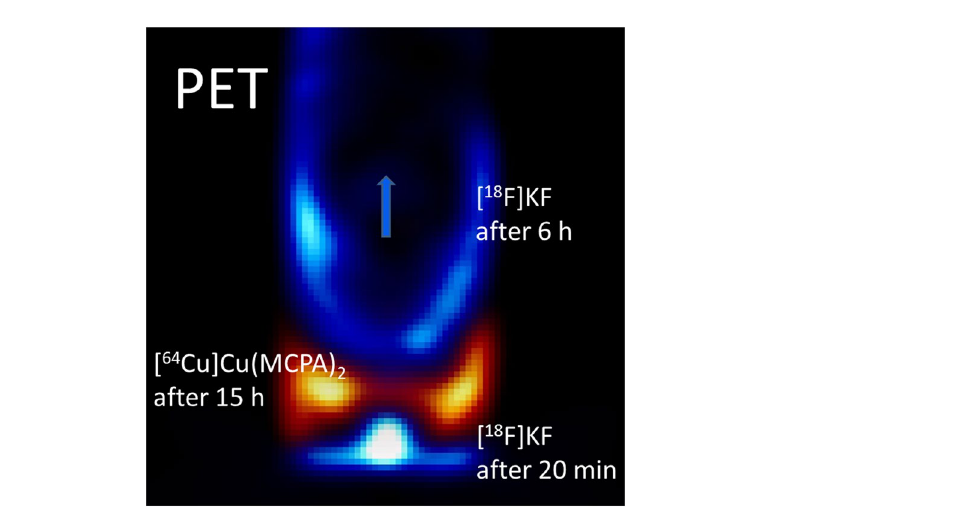
A snapshot shows for different times an overlay of tracer propagation of both the non-reactive [ 18 F]KF tracer experiment #2 (blue colors in Fig. 2) and the reactive [ 64 Cu]Cu(MCPA) 2 tracer experiment #3 (orange colors in Fig. 2). Comparison of the two frames of experiment #2 (20 min and 6 h after injection of the tracer pulse) with one frame of experiment #3 (15 h after injection of the tracer pulse) suggests substantial retardation of the reactive tracer. Only about 66 h into experiment #3 the 64 Cu tracer started to breakthrough. In the replicate experiment #4, first tracer breakthrough was found already at 22 h. The normalized (i.e., decay-corrected) activity continued